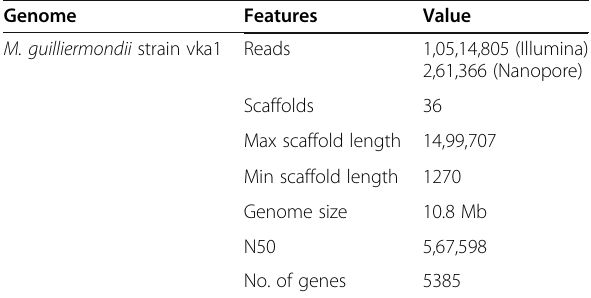
Table 1 Genome features of M. guilliermondii strain vka1 Genome Features